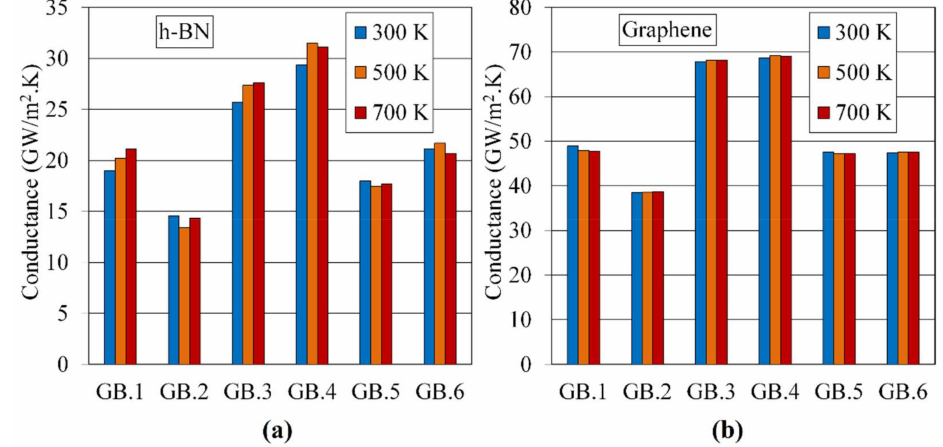
Figure 11. Computed the term of thermal conductance of graphene material for six employed grain boundaries at three temperatures (300 K, 500 K and 700 K) and six grain boundaries. ( a ) h-BN; ( b )